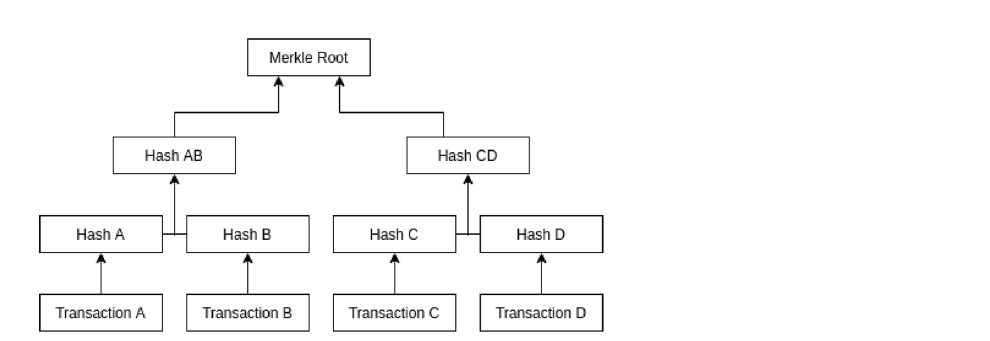
Figure 3. A user centric model 13 .